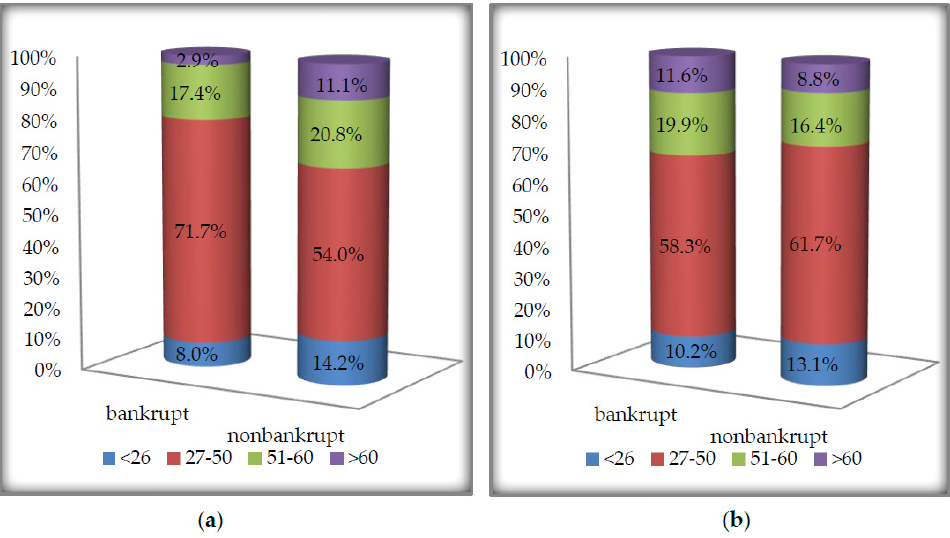
Figure 2. The age structure of bankrupt and nonbankrupt consumers in Taiwan, in the testing sample of: ( a ) female and ( b ) male. Source: Based on own studies. of: ( a ) female and ( b ) male. Source: Based on own